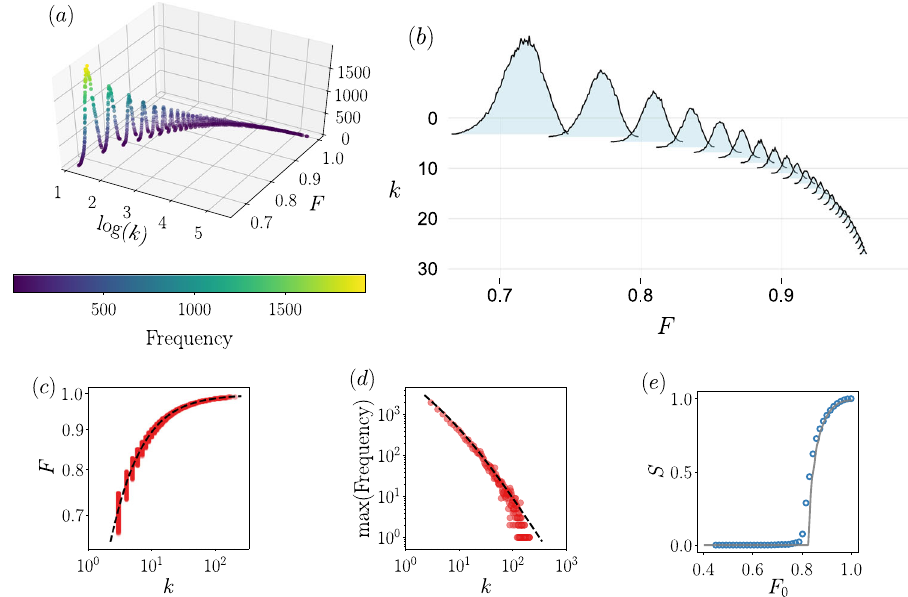
Fig. 5 Feature-enriched percolation of the SIS model. We integrate the dynamical Eq. (19) for a reshuf fl ed Barabási – Albert 70 , with m = 3 and system size N = 2000. A non-normalized histogram of the pairs ( k i , F i ), where the feature value is F i = x i ( t → ∞ ), is shown in ( a ). The input data for the histogram comes from 100 independent realizations. In ( b ), ridge plot of the 25 fi rst curves of the histogram, i.e., those with the lowest degree and highest peaks. The bell shape behavior with varying mean, standard deviation, and peak height can clearly be appreciated. In ( c ), projection of the k − F plain, together with the expressions μ F ( k ) (see text) given by the Bayesian machine scientist method. The standard deviation σ F ( k ) is not shown because it visually overlaps μ F ( k ) for large k . The expressions are μ F ð k Þ ¼ exp ð a 1 = ð b 1 (cid:2) k ÞÞ and σ F ð k Þ ¼ exp ð a 2 = ð b 2 (cid:2) k ÞÞ (cid:2) μ F ð k Þ , and have been obtained imposing only one free parameter per function, namely v = − 1.1641 and w = 0.4317. The constants in the exponential are given by a 1 = − v , b 1 ¼ (cid:2) cosh v ð v 2 Þ , a 2 = 2 w and b 2 ¼ (cid:2) cos 2 ð w Þ . d To fi nd the height of the probability peaks we use the BMS on the pairs of variables ð k ; max ð P ð F j k ÞÞÞ , indicated by points, obtaining h ð k Þ ¼ a 3 x ð b 3 þ x Þ where the free parameter is t = 26.1442 and the constants in the function are a 3 ¼ tan t ð t Þ = 2 and b 3 = t /2, indicated by the solid line. In ( e ), feature- enriched percolation of the SIS model, with the simulation (points) and the theoretical curve obtained from Eq. (21). Each point in ( d ) is averaged over 100 independent realizations of the